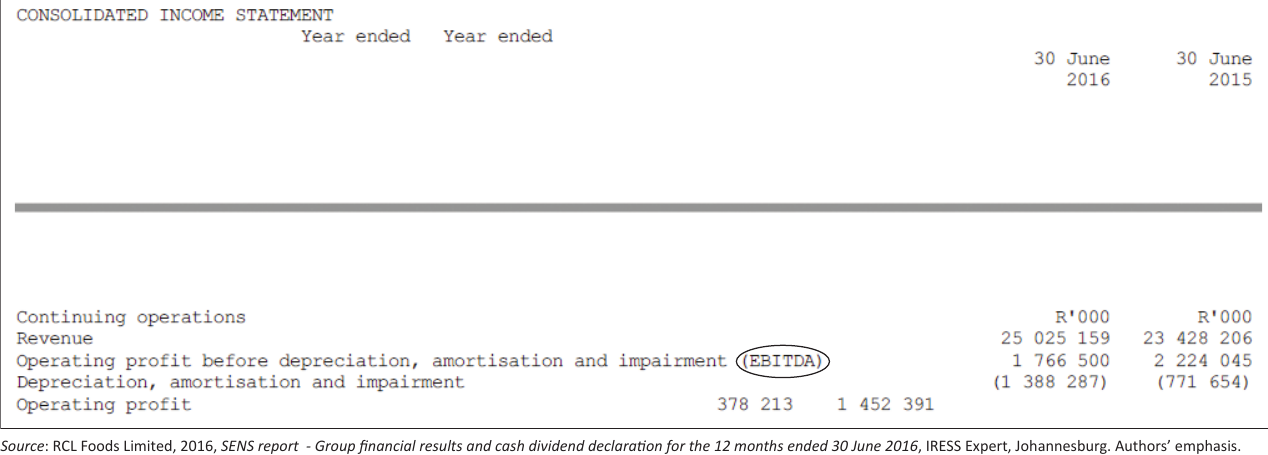
FIGURE 3: Extract from RCL Foods Limited 2016 Stock Exchange News Service report – example of how earnings before interest, tax, depreciation and amortisation was